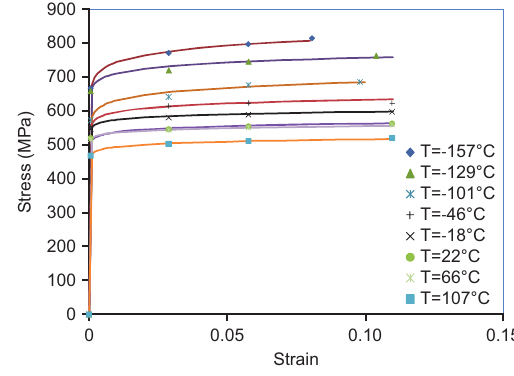
Figure 1 Stress-strain curves of CR-1018 steel for a wide range of temperatures at a shear strain rate of 5 × 10 -4